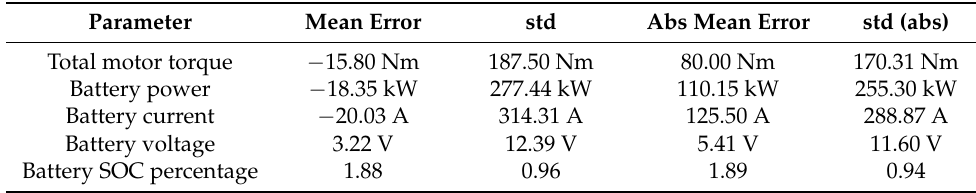
Table 8. Performance indices of the hypercar simulation with the TEST model. Parameter Mean Error std Abs Mean